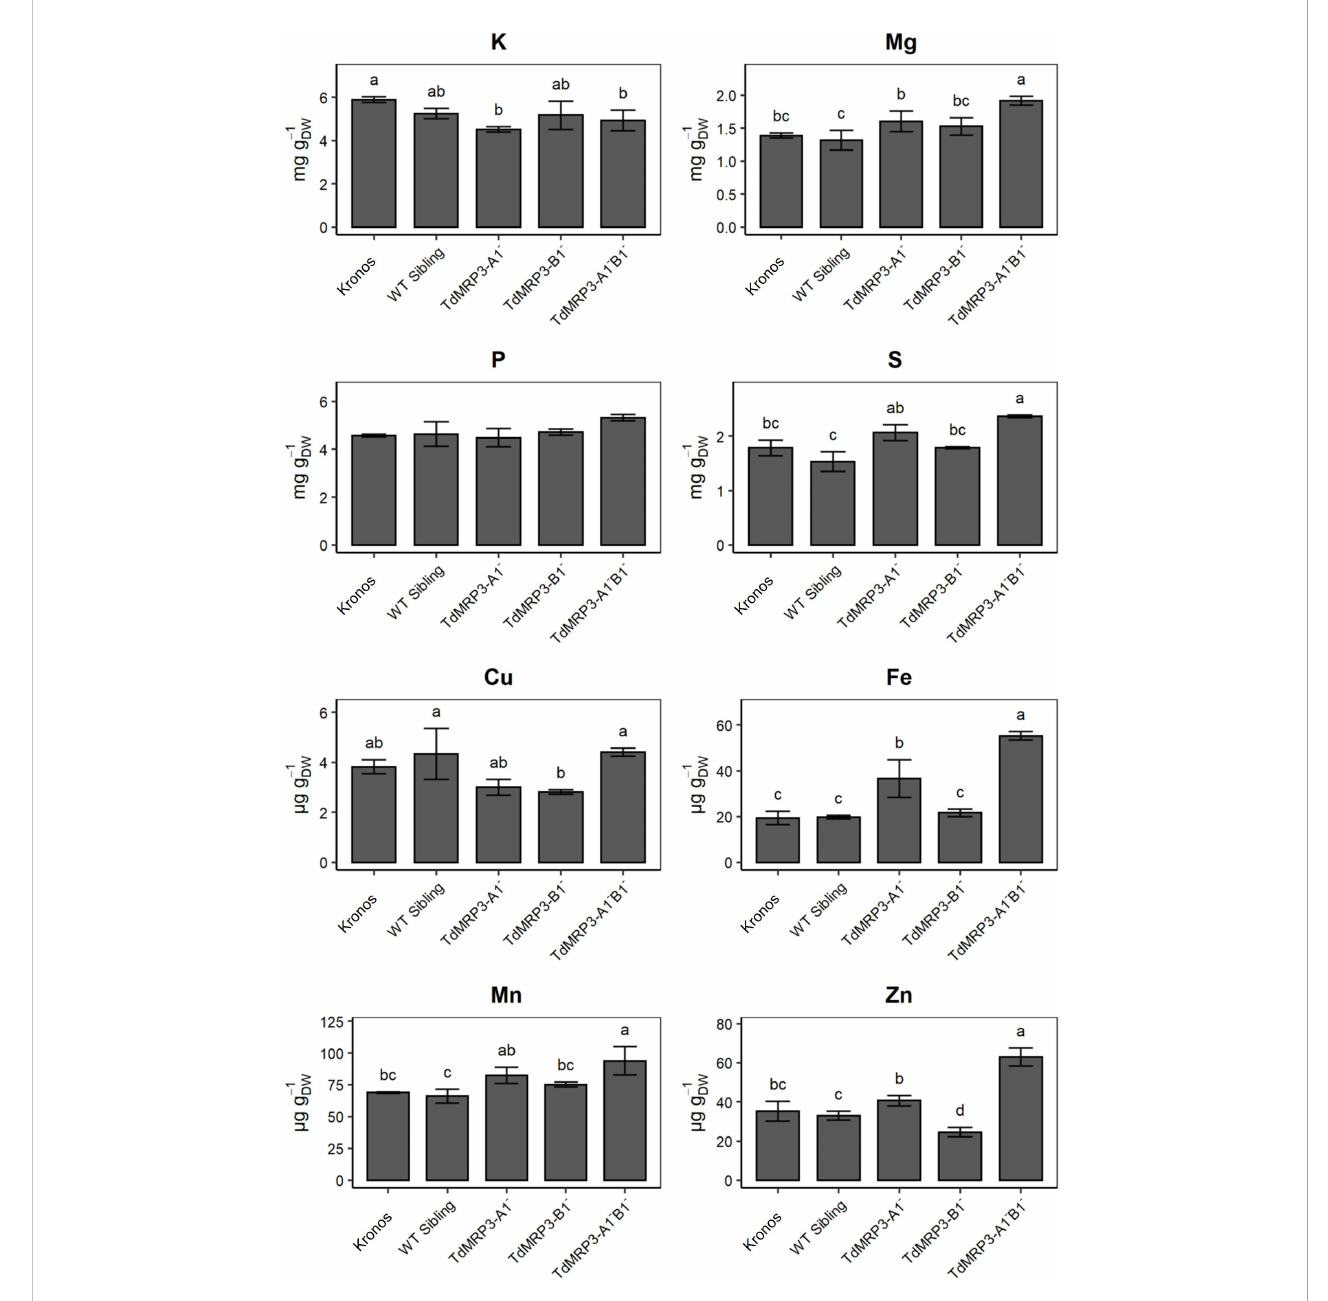
FIGURE 4 Concentration of nutrients in lpa mutants, WT sibling lines and cv. Kronos. Mean values of three biological replicates ± St. Dev. One-way ANOVA, LSD post hoc test, p